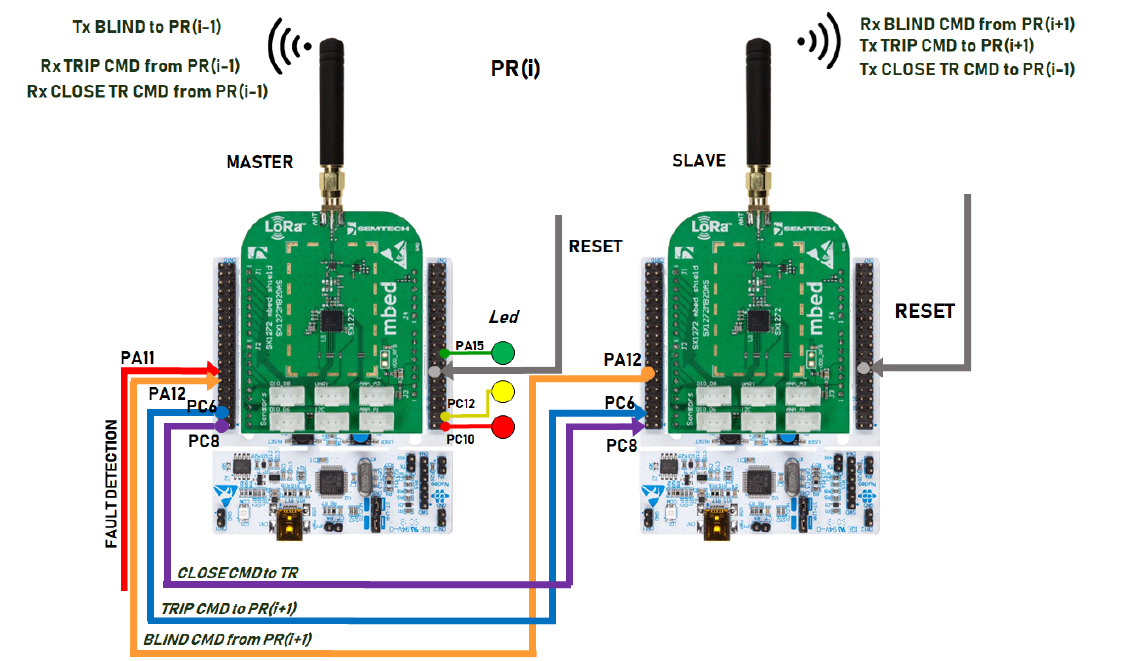
Figure 6. Master-slave architecture that allows the PR (i) to simultaneously communicate with the upstream protection PR (i − 1) and the downstream protection PR (i +